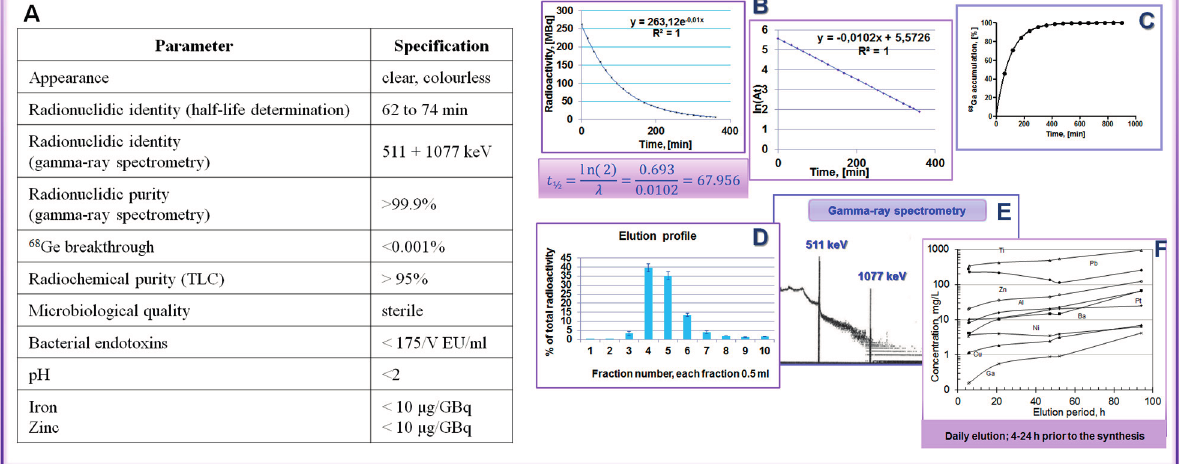
Figure 21. 68 Ge/ 68 Ga generator validation: ( A ) Table summarizing the validation parameters and the respective specifications; ( B ) t ½ determination; ( C ) 68 Ga accumulation; ( D ) elution profile; ( E ) radionuclide purity; and ( F ) recommendation to elute generator prior to the